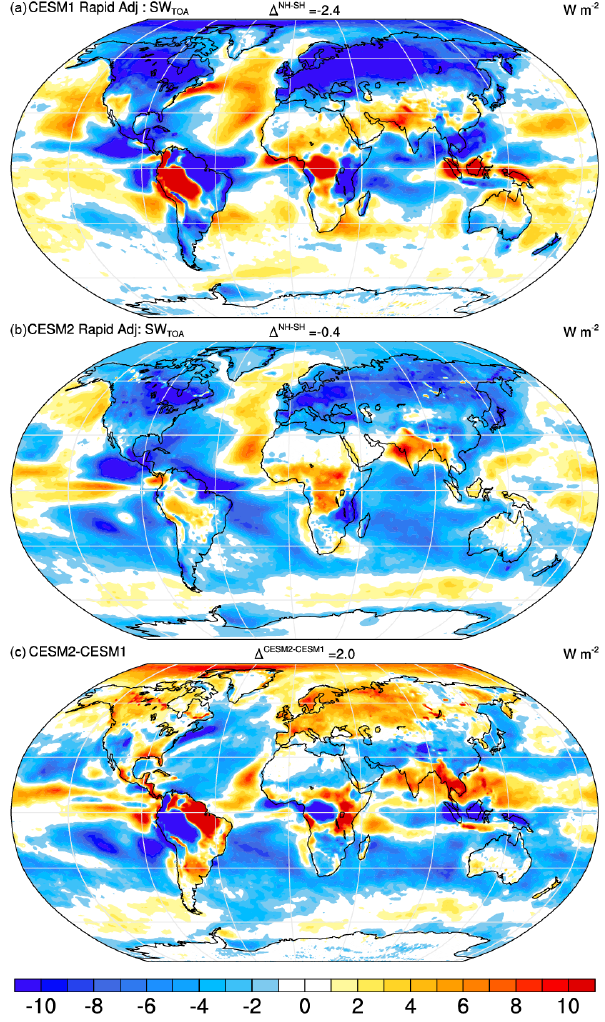
Figure 4. Estimates of the rapid adjustment of TOA net absorbed SW flux to CO 2 for CESM1 (a) , CESM2 (b) , and their differ- ence (c) based on estimates from 4 × CO 2 AMIP and AMIP sim- ulations. Differences in the hemispheric means are shown in panel titles. All units are Wm − 2